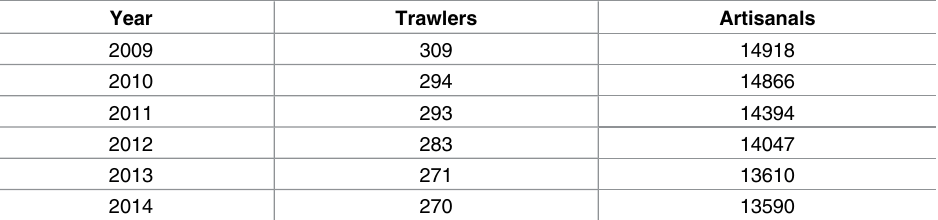
Table 3. Evolution of the fleet size, in terms of numbers of vessels, from